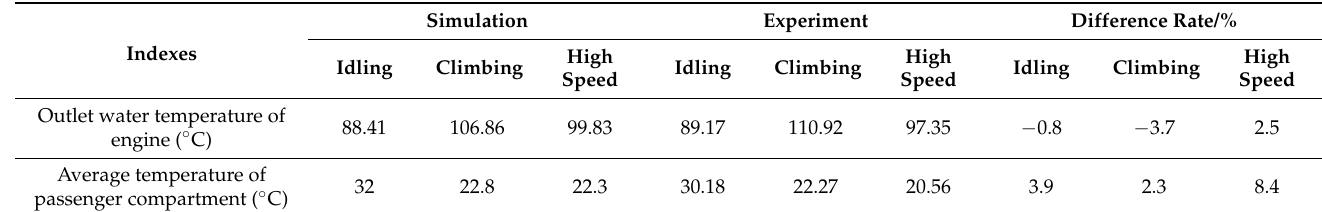
Table 4. Comparison of simulation results and experimental results.